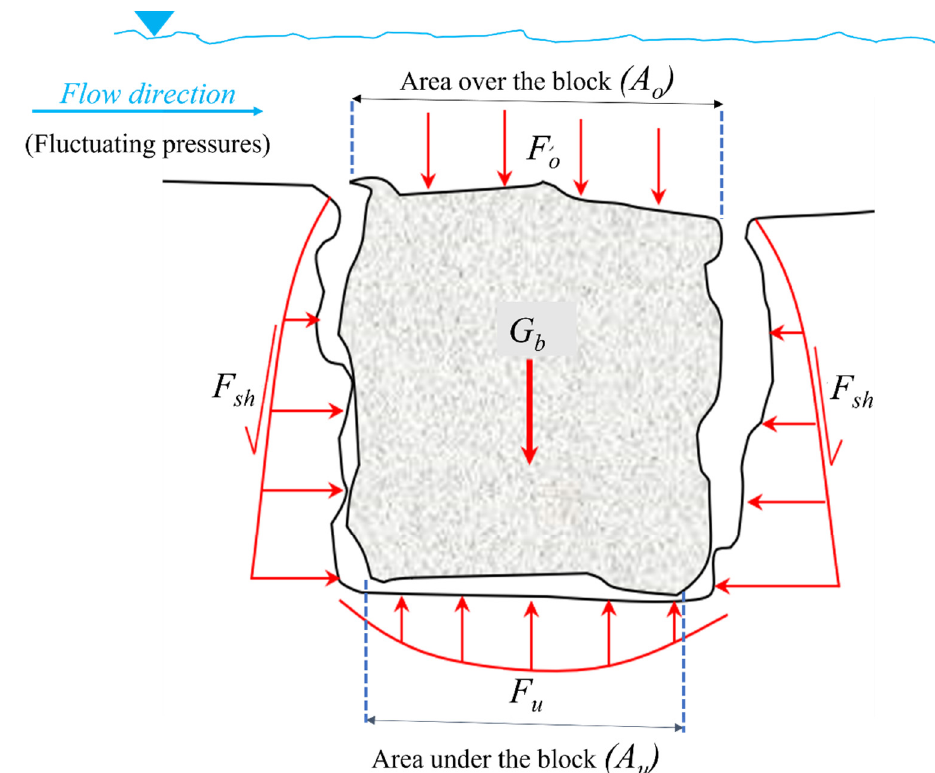
Figure 13. Conceptualisation of impulse dynamics on a block, based on the Bollaert DI method [59]. Kinetic and potential energies have been used in Equation (26) for determining the uplift height ( h up ) (m) from Equation (27) and comparing with block height ( Z b ) (m).